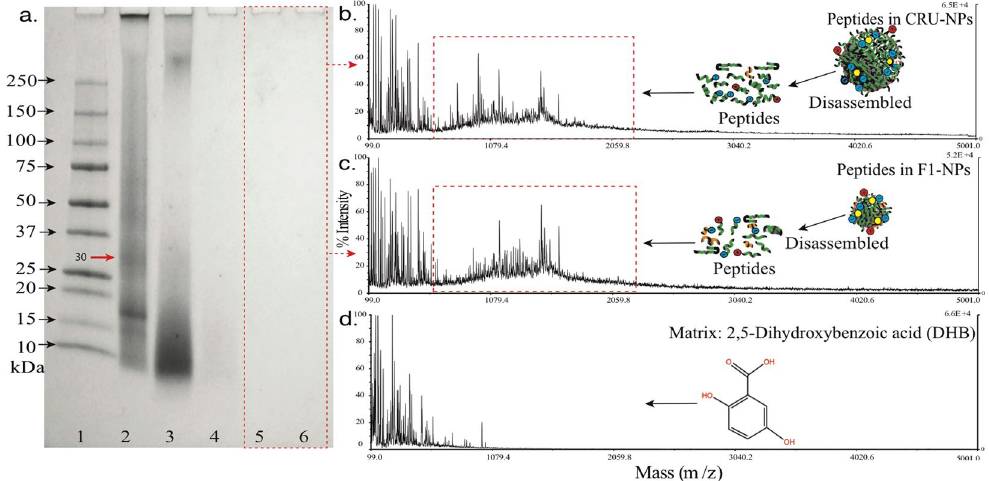
Figure 5. ( a ) SDS-PAGE of cruciferin samples in the presence of 5% ME (lanes 1, marker; lane 2, cruciferin (control); lane 3, CRU (cruciferin peptides); lane 4, F1 (cruciferin peptide fraction < 10 kDa); lane 5, CRU-NPs (nanoparticles formed from cruciferin peptides); lane 6, F1-NPs (nanoparticles formed from cruciferin fraction < 10 kDa)). Matrix-assisted laser desorption/ionization time-of-flight (MALDI-TOF) mass spectrometry of peptides disassembled from ( b ) F1-NPs, ( c ) CRU-NPs, and ( d ) matrix, 2,5-Dihydroxybenzoic acid